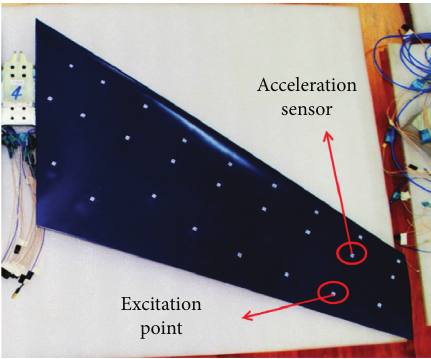
Figure 15: Test horizontal